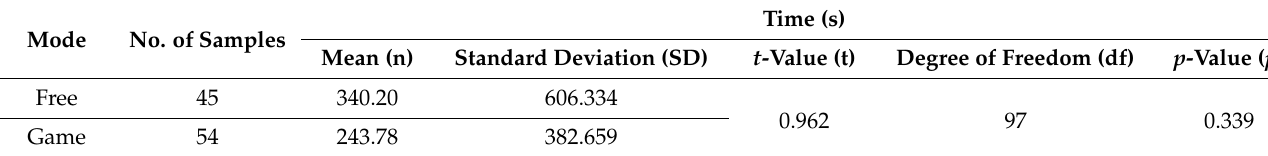
Table 1. Summary table of t -test of exhibition-viewing time.